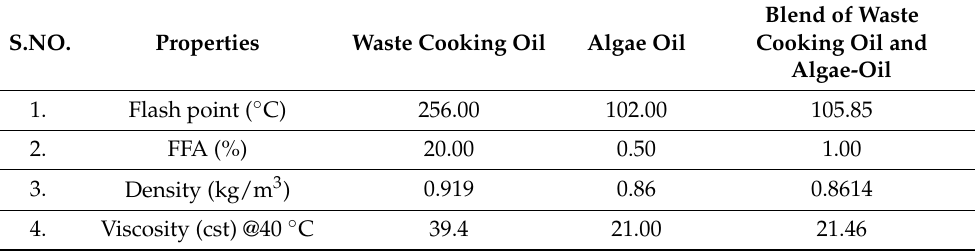
Table 1. Properties of Waste Cooking oil &